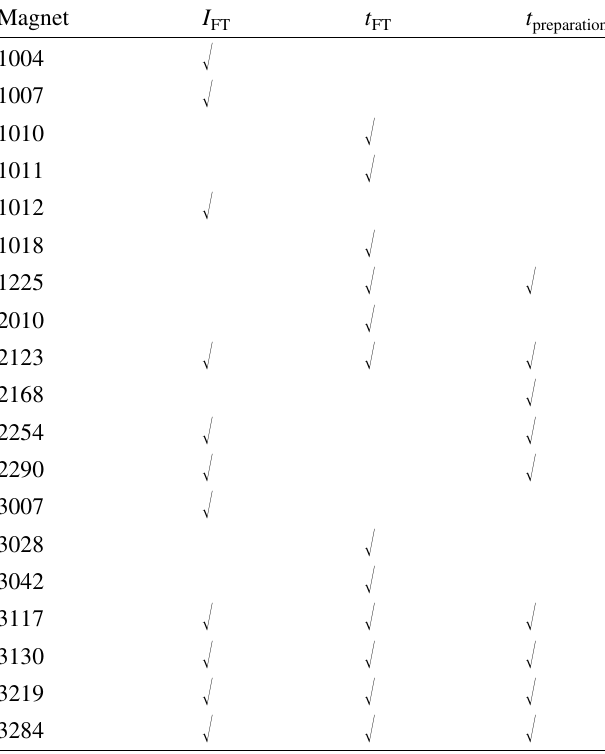
, (b) b , and (c) b 1 3 5